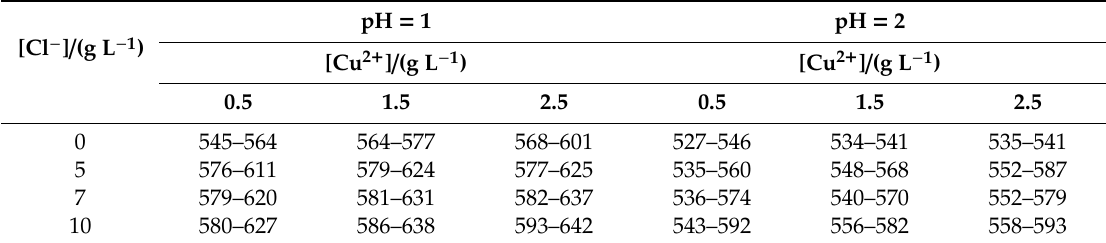
Table 2. Range of redox potential or each test conducted.